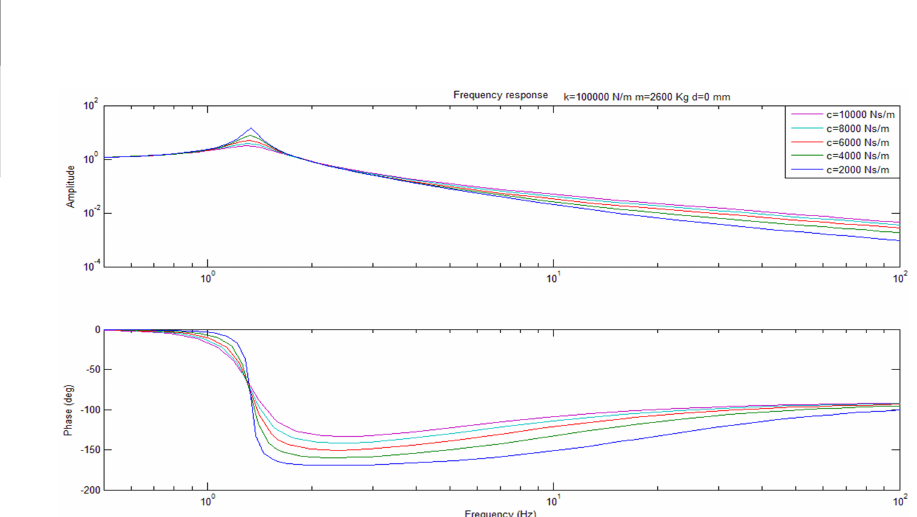
Figure 4 – Transfer function of vertical displacement for different damping values Slika 5 – Prenosna funkcija vertikalnog pomeranja za razli č ite vrednosti prigušenja Рис . 5 – Передаточная функция вертикального смещения при различных коэффициентах затухания